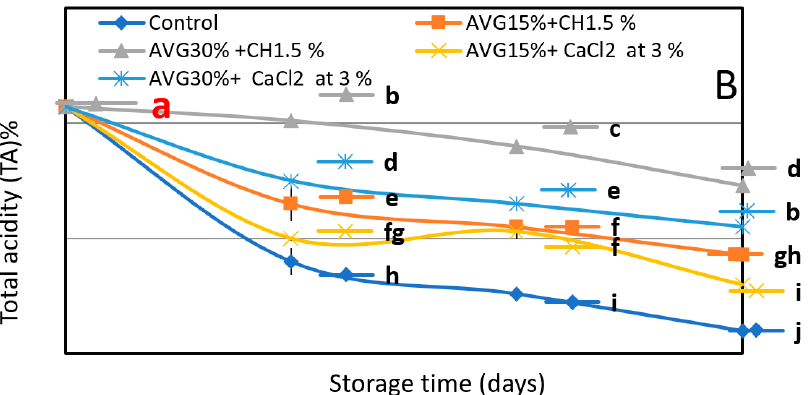
Figure 1. The effect of coating with AVG at 15 and 30% mixed with CH at 1.5% or CaCl 2 at 3% on TSS% ( A ), and TA% ( B ) of ‘sultany’ peaches during cold storing at 3 ± 1 °C and 95 ± 1% RH for 36 days. The standard error (±SE of n = 3) is shown by the vertical bars, and the alphabetical letters indicated the significance at p ≤ 0.05 among treatments in each storing period. The average of both trial seasons (2020 and 2021) was analyzed by using Duncan’s Multiple Range Test. p -value of TSS%, F1 = 0.448 F2 = 0.501 F1 × F2 = 1.027 and TA%, F1 = 0.033 F2 = 0.037 F1 × F2 = 0.076.